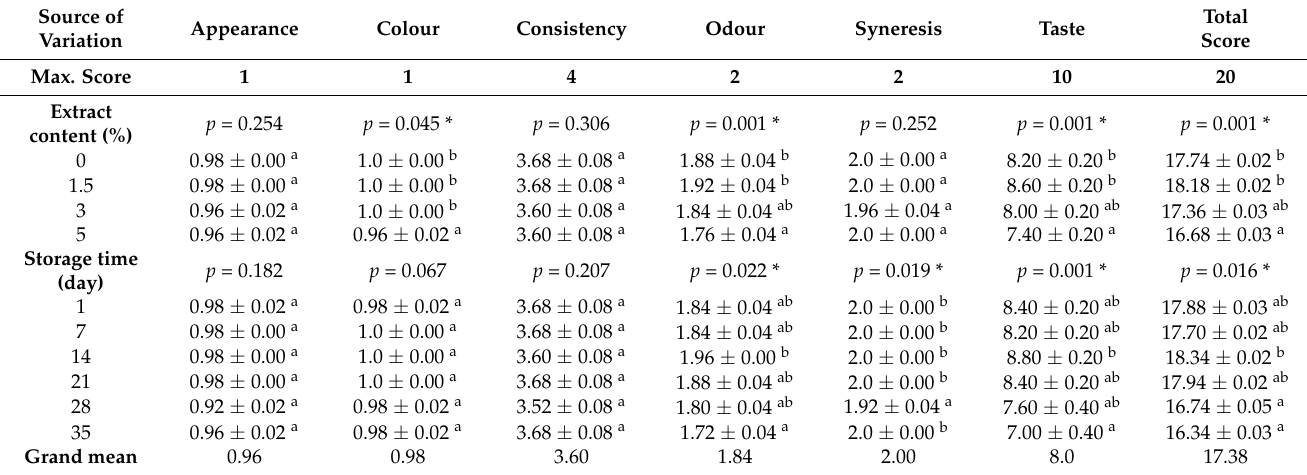
Table 5. Influence of extract content (%) and storage time on sensorial properties of yoghurts enriched with olive leaves